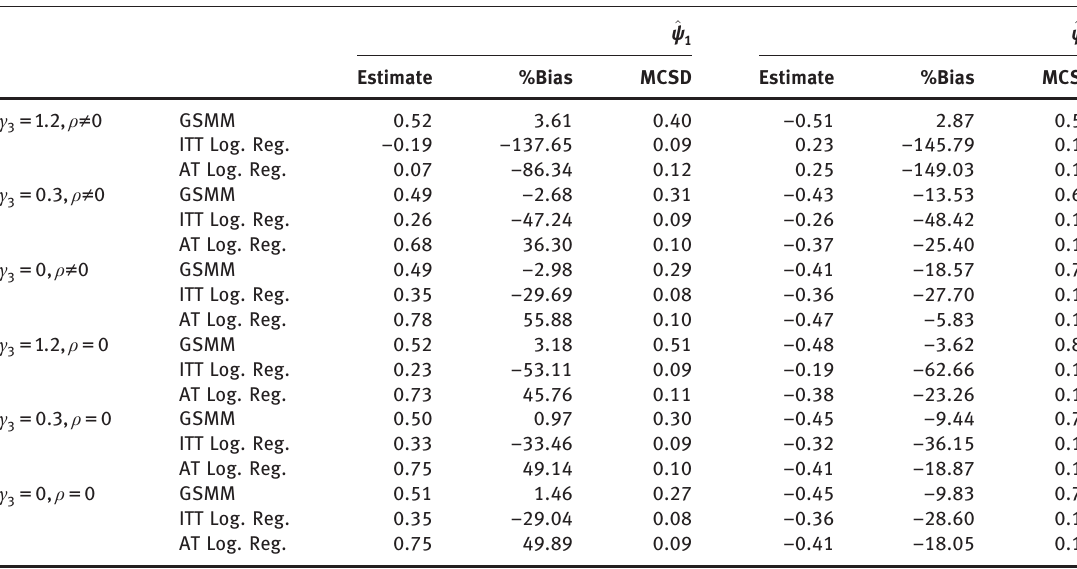
Table 2: Simulation study results. Mean estimates, percent bias, and Monte Carlo standard deviations of the modified G-estimation and standard logistic regression when nonignorable noncompliance is present. ρ X characterizes the association between baseline covariates X , and ð γ , γ characterize the association of X and S . γ is the coefficient of A in the data- 1 2 Þ 3 generating model for S . ρ =0 indicates that S does not predict Y 0 . The first row in each parameter configuration corresponds to the G-estimation; the second row reports estimates from the intent-to-treat logistic regression; the third row is the as-treated logistic